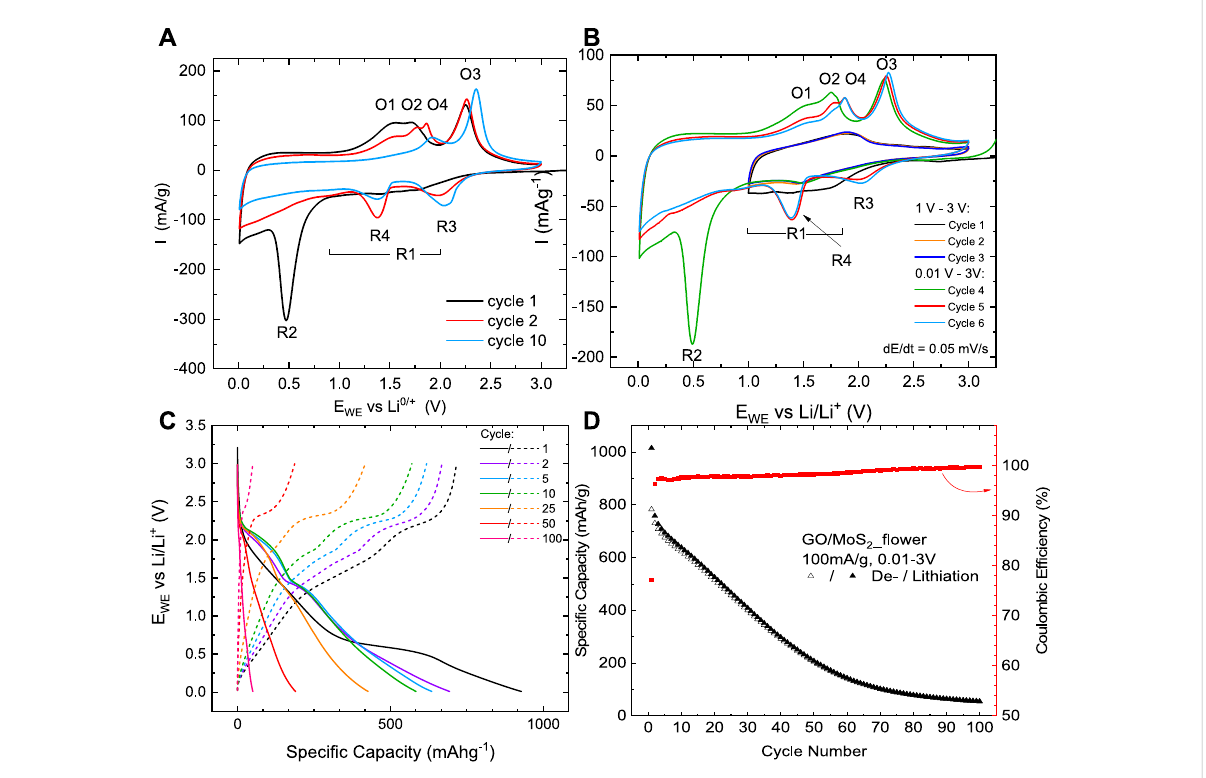
FIGURE 4 (A) Cyclicvoltammograms ofGO/MoS 2 -typeelectrodesrecordedatascan rateof0.05 mV/s, (B) CVofGO/MoS 2 atascanrateof0.05 mV/s in the potential range from 1.0 to 3 V in the fi rst three cycles and subsequently in the potential range of 0.01 to 3 V of cycles 4, 5 and 6. (C) Potential pro fi le of galvanostatic cycling of GO/MoS 2 at 100 mA/g between 0.01 and 3 V at speci fi c cycles. (D) Speci fi c charge/discharge capacities and associated Coulombic ef fi ciencies during the fi rst hundred cycles studied by GCPL at 100 mA/g.